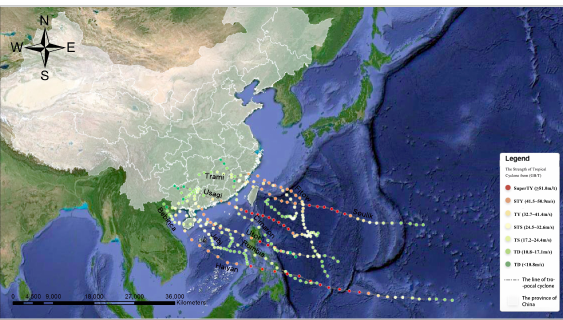
Figure 1. The path of 10 selected tropical cyclones in 2013